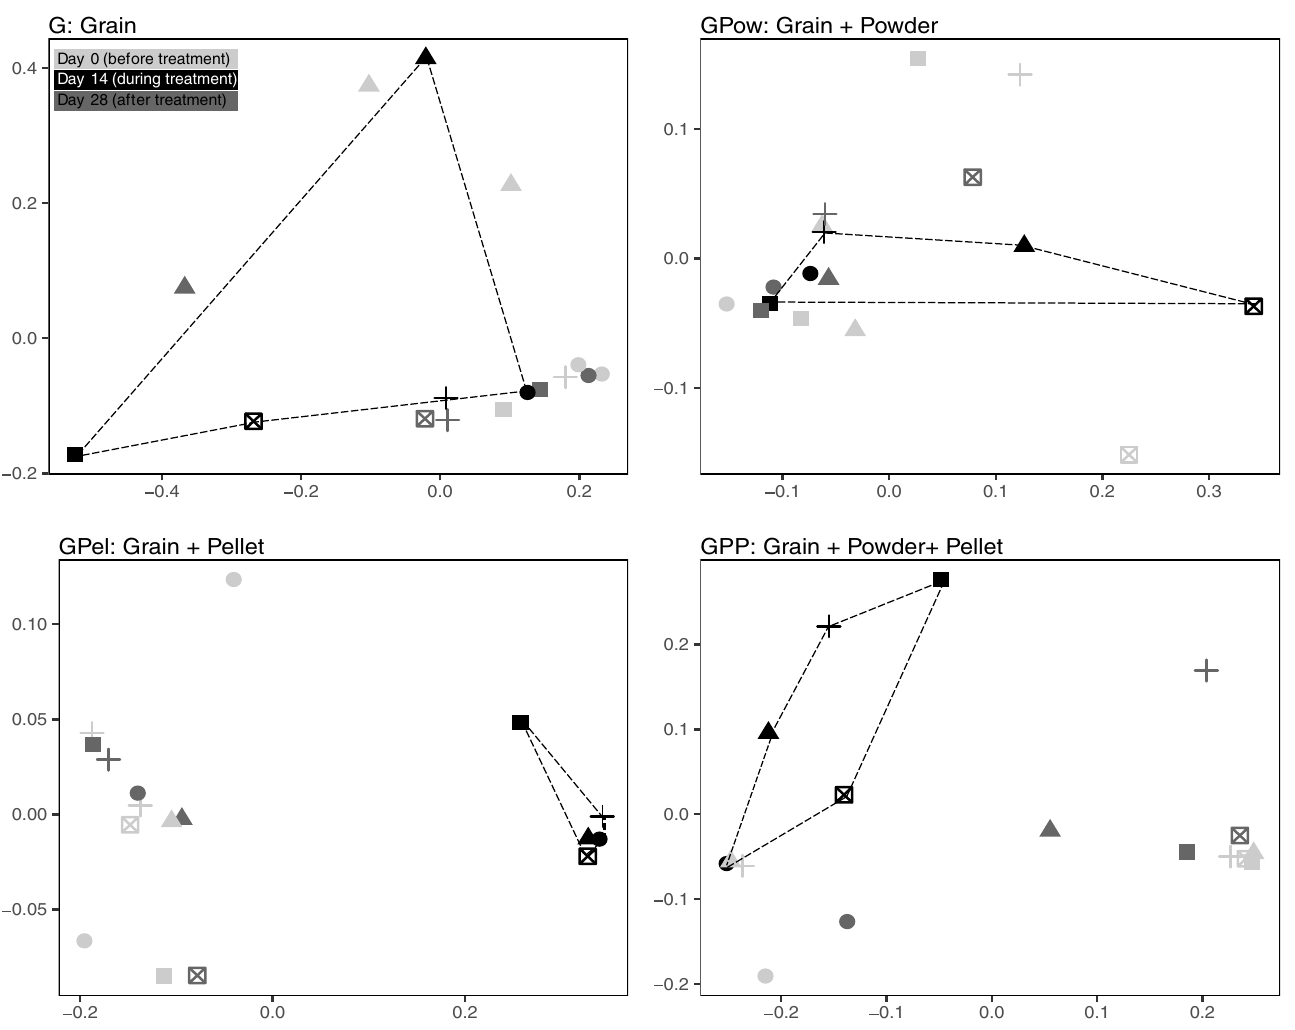
PLOS ONE | https://doi.org/10.1371/journal.pone.0217804 June 17,